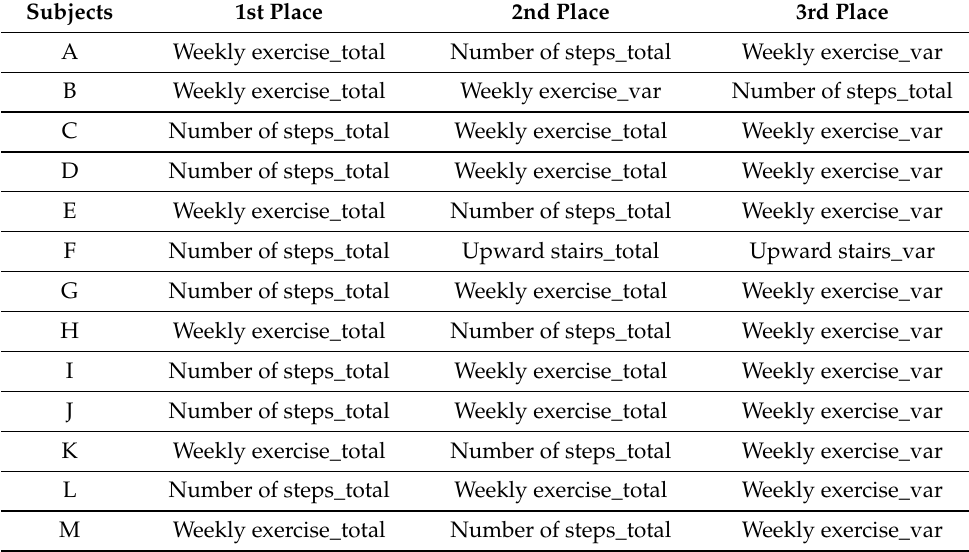
Table 9. Important variables in behavior modification stage